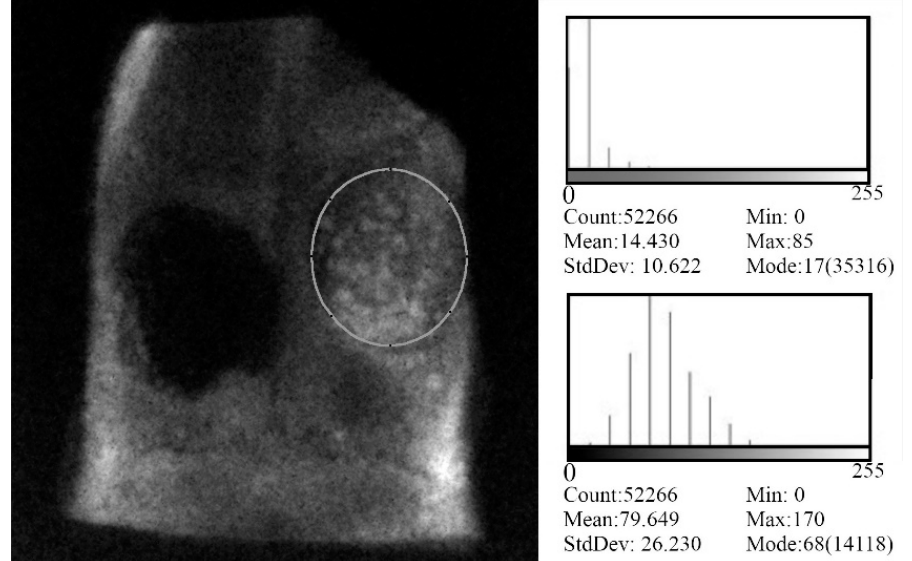
Figure 4 . Evaluation of the radiographic bone density and Histogram, 9 weeks after treatment and after excision of bone defects.